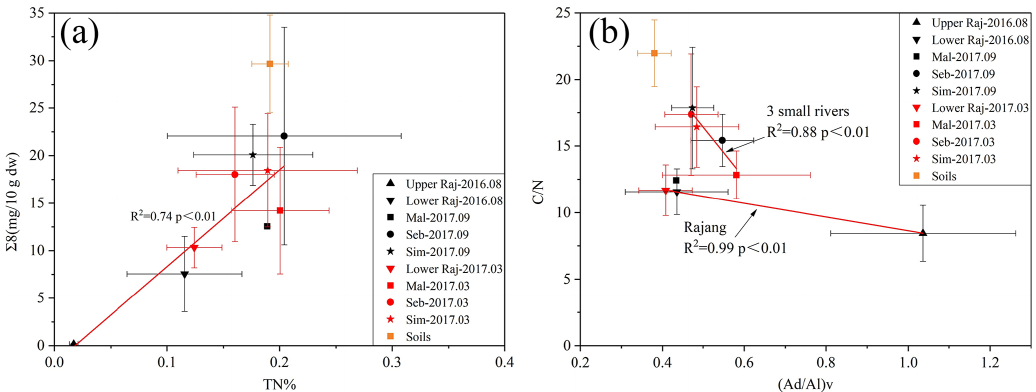
Figure 6. (a) Correlation of TN% with (cid:54) 8 based on average values of the studied systems. (b) Correlation of ( Ad / Al ) V with C / N ratio based on average values of the studied